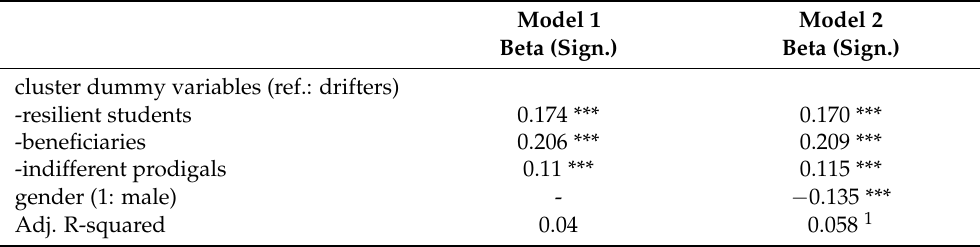
Table 4. Coefficients of linear regression models with the principal component of persistence as dependent